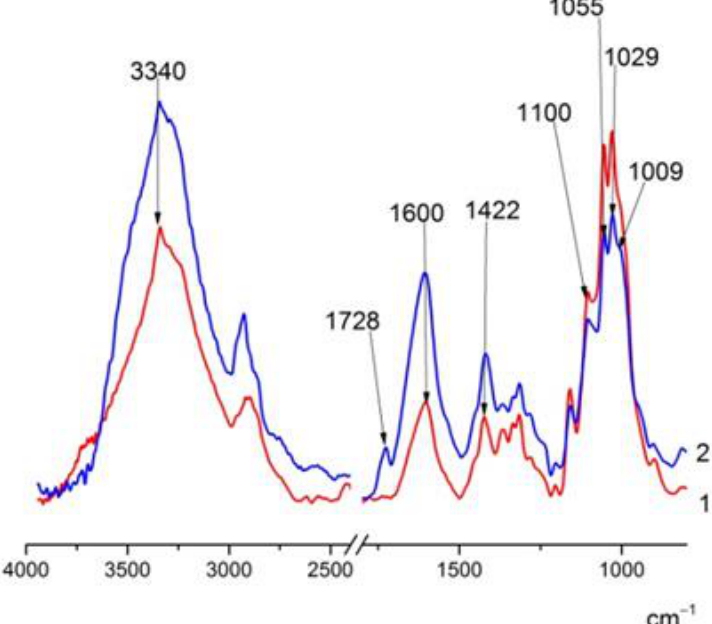
Figure 2. FTIR spectra: (1) BC – ALG – chitosan (CS_), (2) BC – ALG(CeONP) – CS.